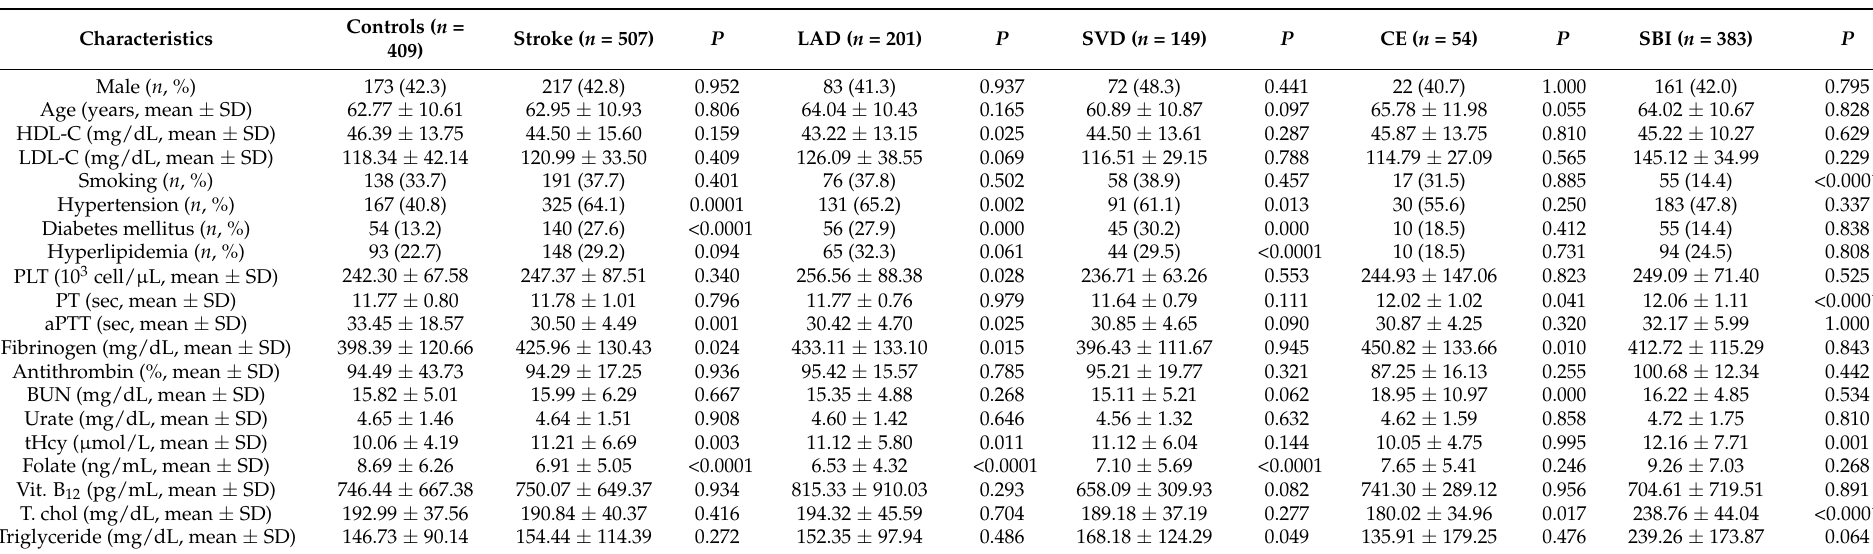
Table 1. Baseline characteristics of control subjects, stroke patients and subsets, and silent brain infarction